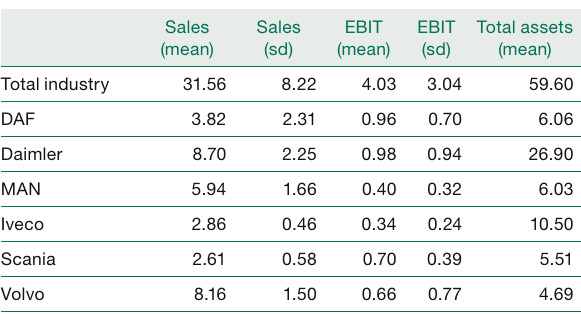
Firm-level details on data availability